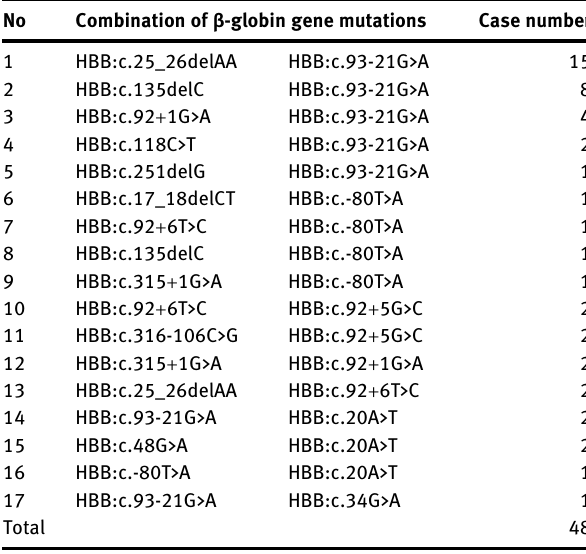
Table  : Compound heterozygote patients in the region. No Combination of β -globin gene mutations Case number